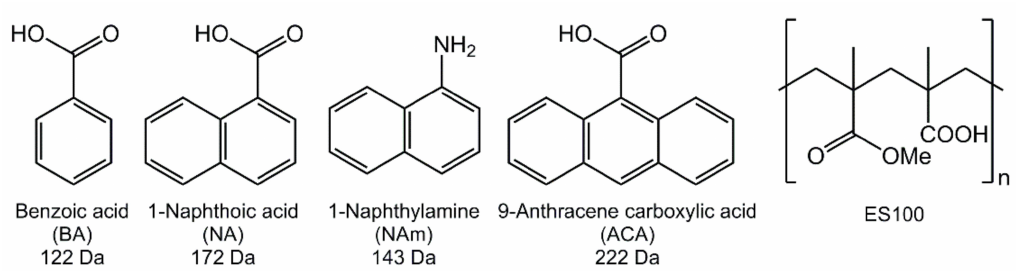
Figure 1. The chemical structures of the active ingredients used in this work and their molecular weights, together with the structure of the polymer ES100. BA: Benzoic acid; NA: 1-naphthoic acid; NAm: 1-Naphthylamine; ACA: 9-anthracene carboxylic acid; ES100: Eudragit S100.